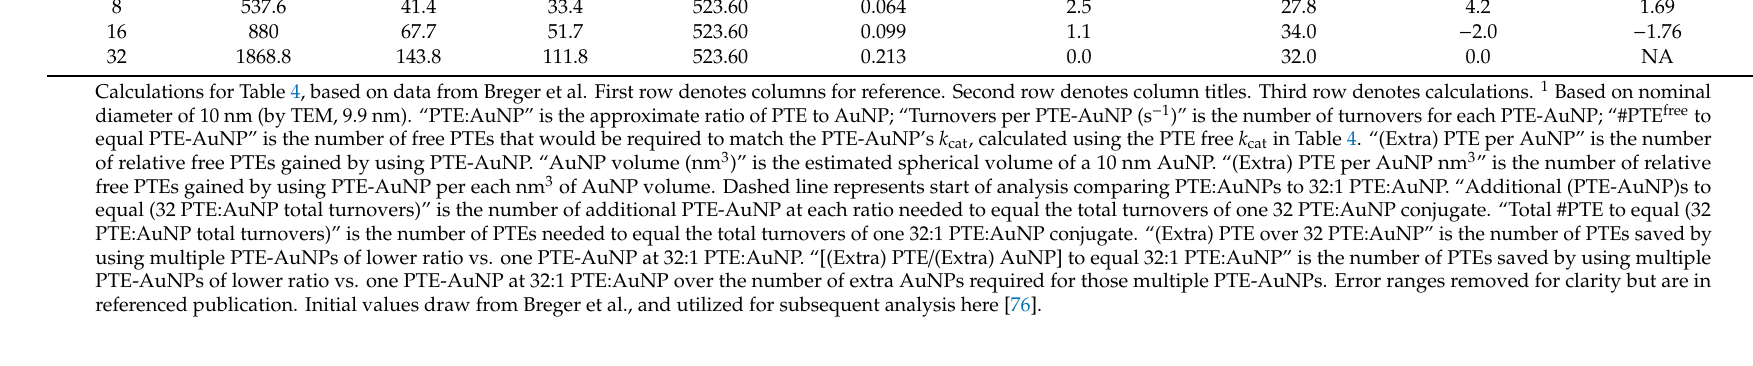
Calculations for Table 4, based on data from Breger et al. First row denotes columns for reference. Second row denotes column titles. Third row denotes calculations. 1 Based on nominal diameter of 10 nm (by TEM, 9.9 nm). “PTE:AuNP” is the approximate ratio of PTE to AuNP; “Turnovers per PTE-AuNP (s − 1 )” is the number of turnovers for each PTE-AuNP; “#PTE free to equal PTE-AuNP” is the number of free PTEs that would be required to match the PTE-AuNP’s k cat , calculated using the PTE free k cat in Table 4. “(Extra) PTE per AuNP” is the number of relative free PTEs gained by using PTE-AuNP. “AuNP volume (nm 3 )” is the estimated spherical volume of a 10 nm AuNP. “(Extra) PTE per AuNP nm 3 ” is the number of relative free PTEs gained by using PTE-AuNP per each nm 3 of AuNP volume. Dashed line represents start of analysis comparing PTE:AuNPs to 32:1 PTE:AuNP. “Additional (PTE-AuNP)s to equal (32 PTE:AuNP total turnovers)” is the number of additional PTE-AuNP at each ratio needed to equal the total turnovers of one 32 PTE:AuNP conjugate. “Total #PTE to equal